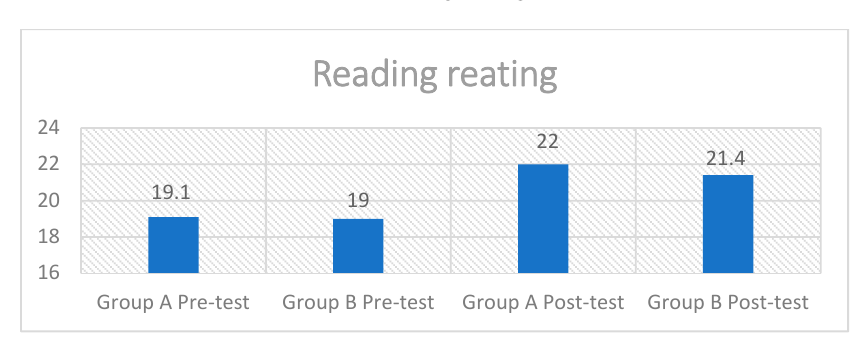
Figure 2. Reading testing results. Appl. Sci. 2020 , 10 , 7022